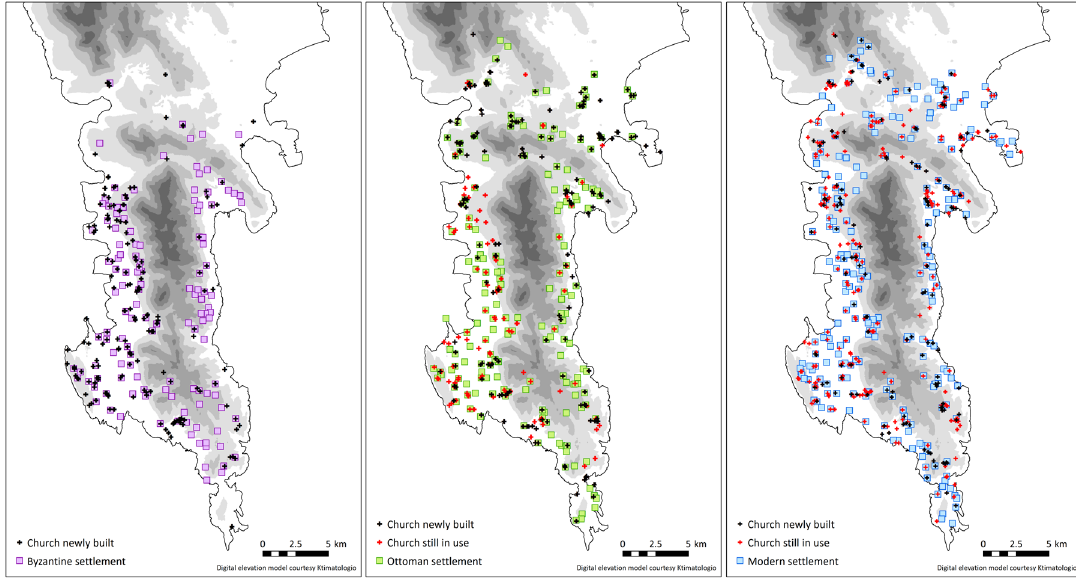
Figure 3. Location of the churches and permanent settlements dated to the (a) Byzantine, (b) Ottoman, and (c) Modern